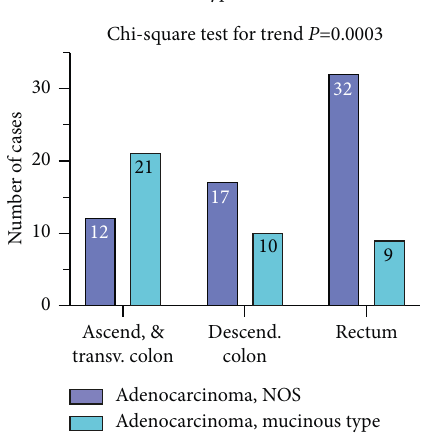
Figure 3: Correlation between anatomical location of the tumor and histologic type NOS (not otherwise specified).